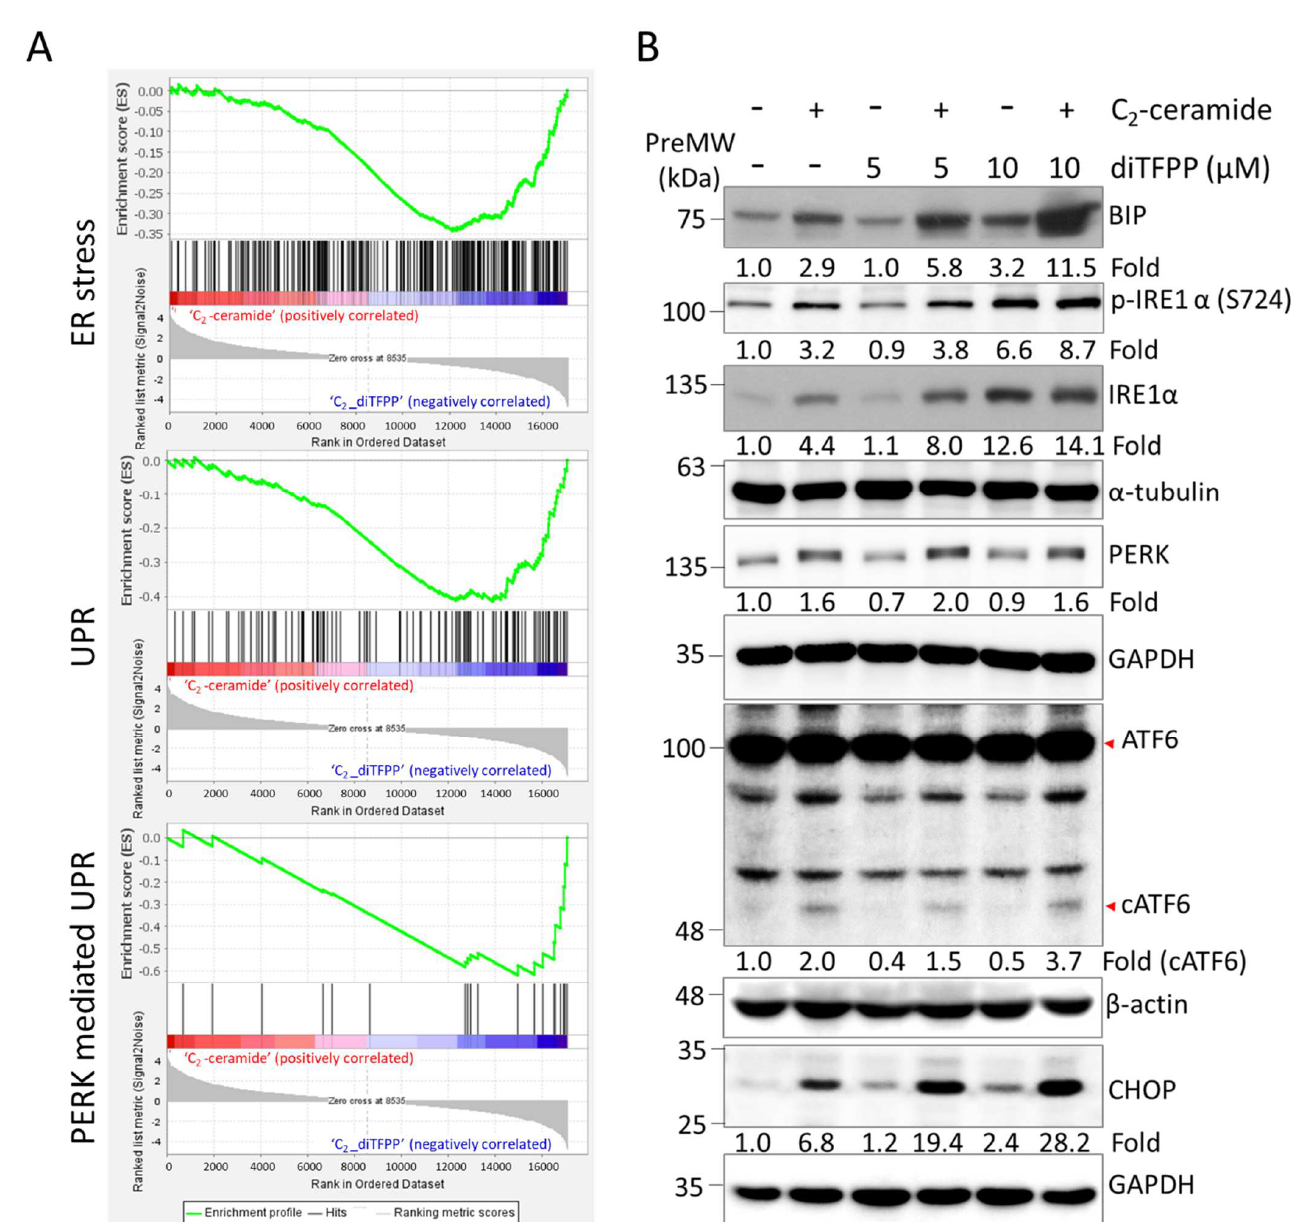
Figure 3. diTFPP mediated ER stress upon cotreatment with 20 μM C 2 -ceramide for 24 h. ( A ) GSEA of C 2 -ceramide-treated cells compared with diTFPP/C 2 -ceramide-treated cells indicated that ER stress response genes were upregulated in the diTFPP/C 2 -ceramide treatment group. ( B ) Western blot analysis of three major ER stress pathway markers. PreMW: prestained protein molecular weight marker (see Section 2.4).